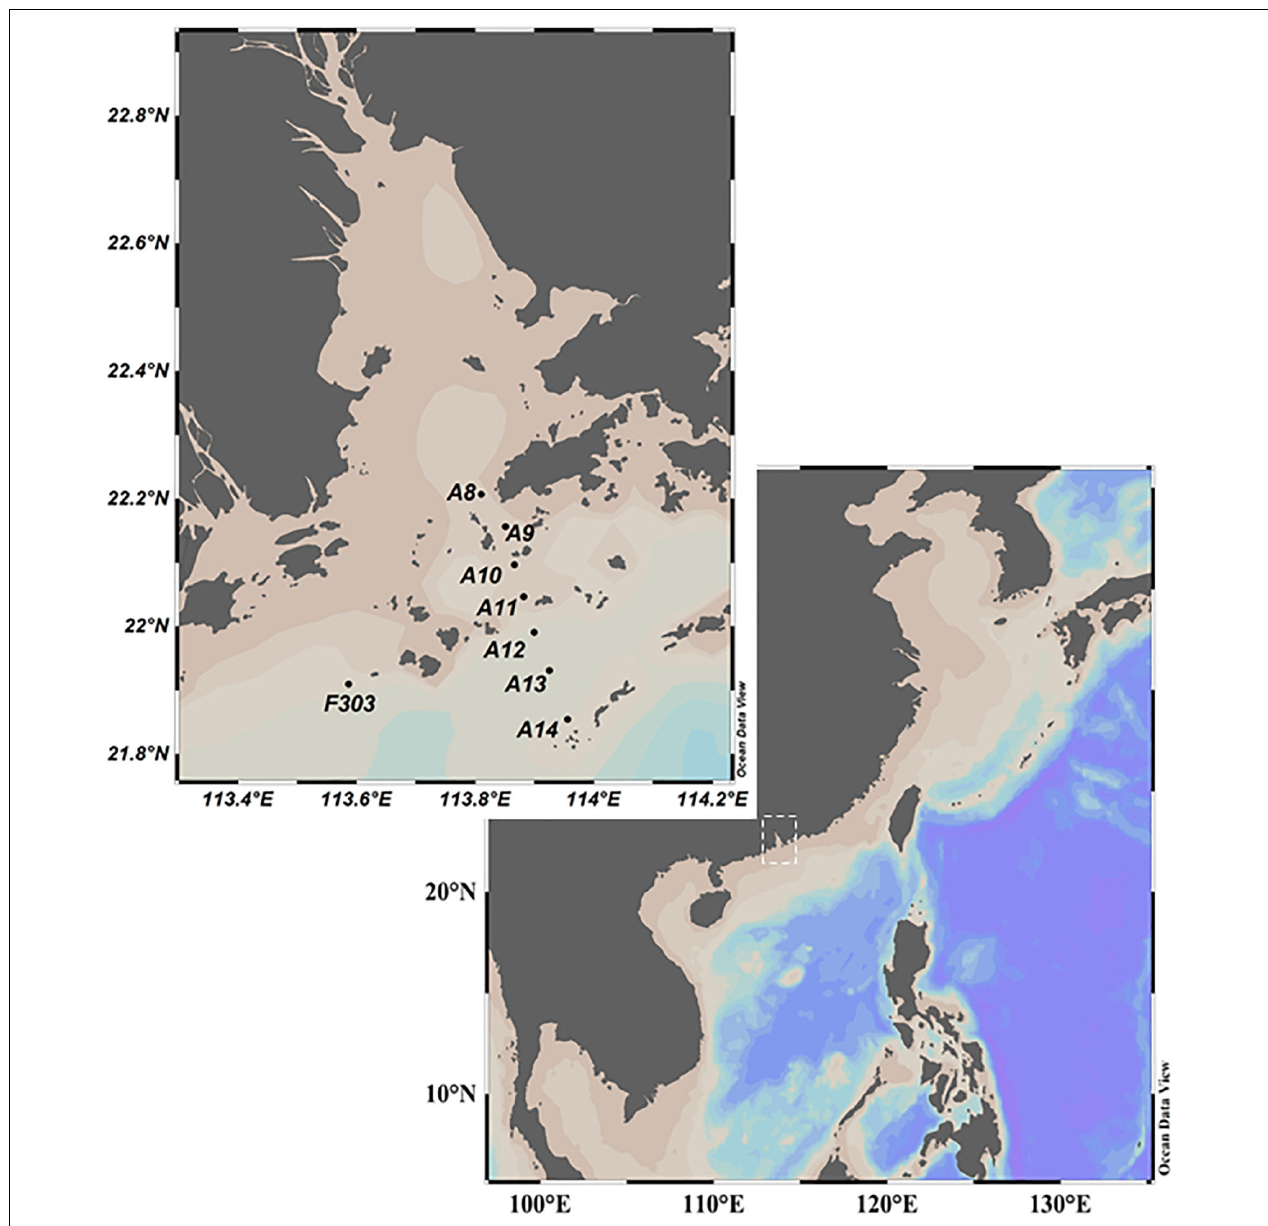
FIGURE 1 | Location of sampling sites on the shelf of the northern South China Sea (NSCS) in July 2018. Figure was produced using Ocean Data View (version 5.1.7).